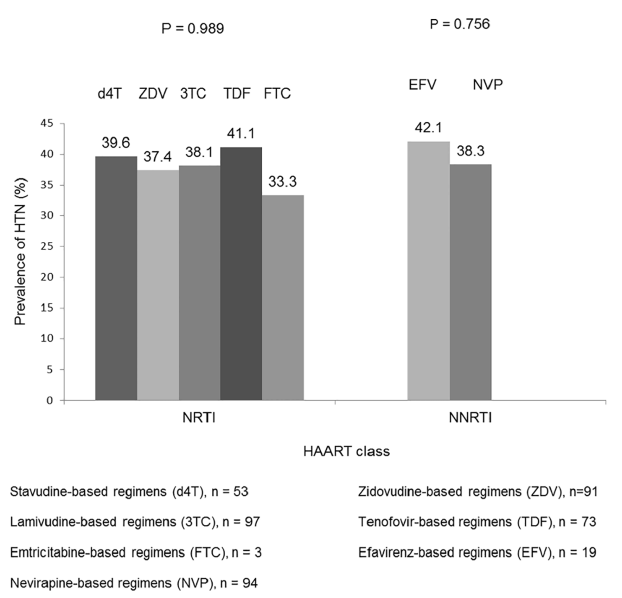
Fig 2. Prevalence of Hypertension in participants with respect to antiretroviral drug ever